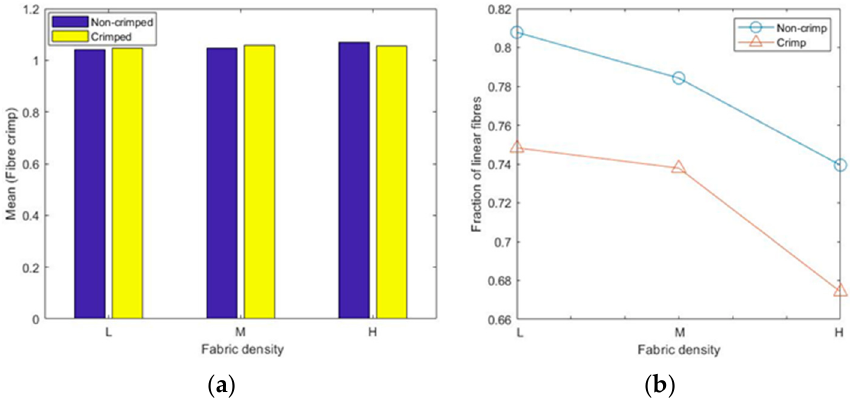
Figure 9. Fibre crimp results: ( a ) mean crimp and ( b ) fraction of linear fibres.